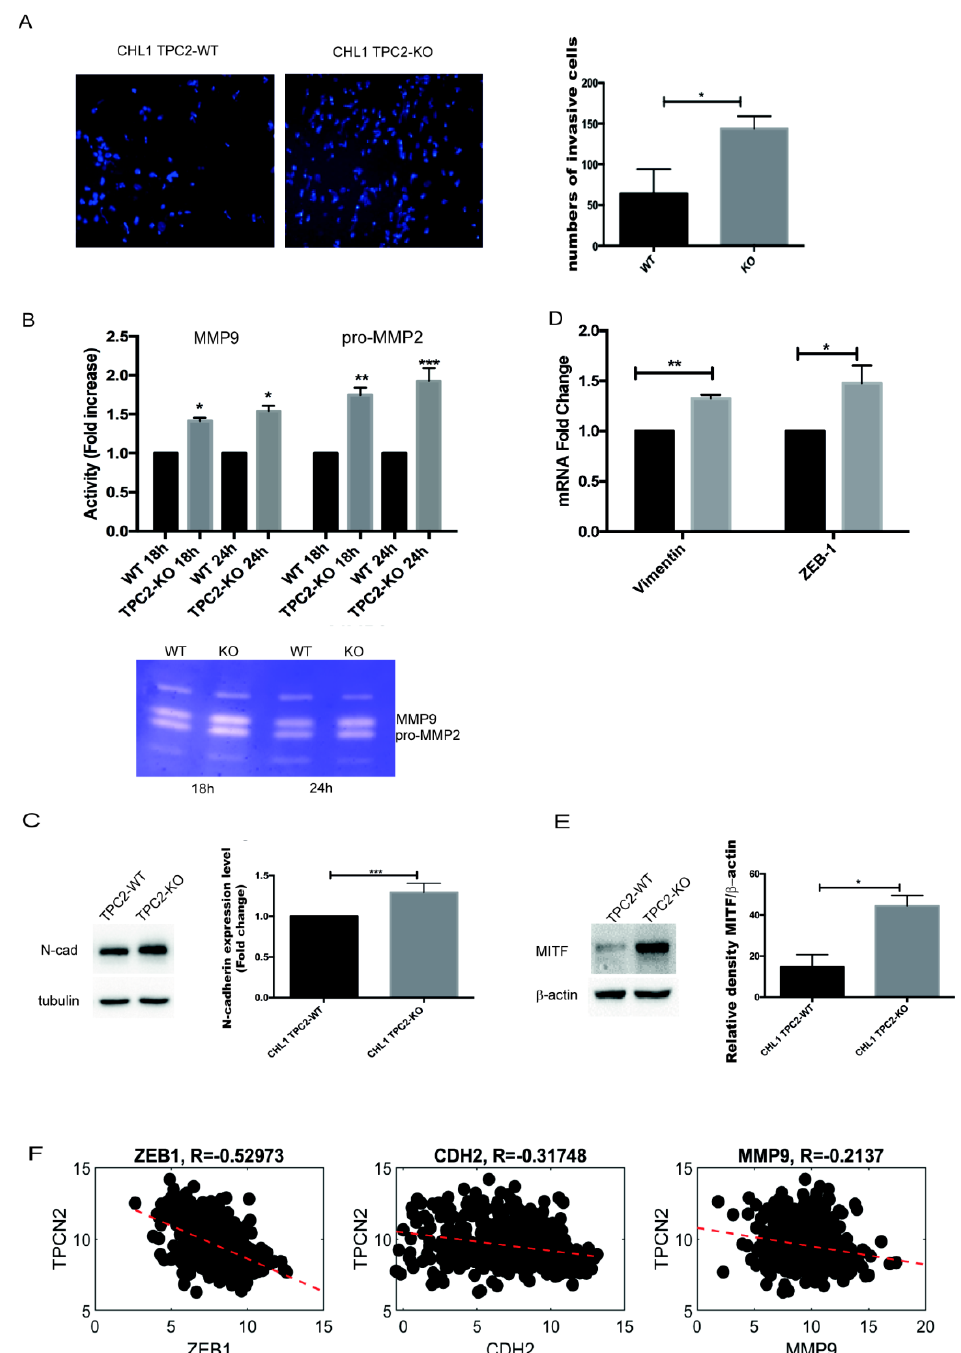
Figure 3. TPC2 depletion increases metastatic melanoma cell invasion. ( A ) Transwell assay after 24 h incubation on matrigel matrix, cell nuclei stained with DAPI. ( B ) Proteolytic Matrix Metalloproteinases (MMPs) activity in CHL1 WT and TPC2 KO cells detected by zymography. Active MMP-9 (82 kDa) and proMMP-2 (72 kDa). ( C ) N-cadherin protein expression in CHL1 WT and TPC2 KO cells, normalised to tubulin. Relative density of N-cadherin / tubulin. ( D ) qPCR analysis of vimentin and ZEB1 in CHL1 WT and TPC2 KO cell lines. H3 was used as an internal control. ( E ) MITF protein expression in CHL1 WT and TPC2 KO normalised to β -actin. Relative density of MITF / β -actin. ( F ) Correlation between TPCN2 and ZEB1, N-Cadherin (CDH2), and MMP-9 in human SKCM. Data in bar charts represent the mean ± s.e.m. of three independent experiments (* p < 0.05; ** p < 0.001; *** p <